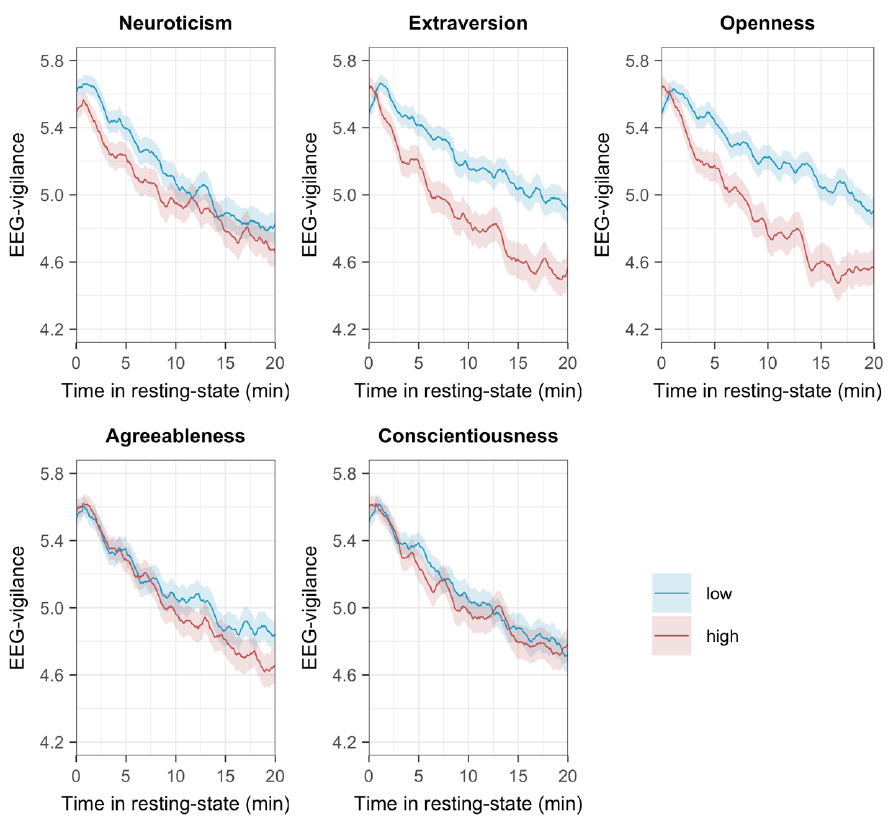
Figure 1. Time-courses of EEG-vigilance during the 20-min eyes-closed resting-state condition stratified by groups scoring low vs. high on the respective Big Five scale (median-split, i.e., participants with scores in the lower vs. upper half of the ascending distribution are compared). Time-courses reflect simple moving averages (± standard errors), i.e., every data point represents an averaged 61-s interval of EEG-vigilance (data point in time ± 30 s). Statistical analyses revealed significant associations between EEG-vigilance and both extraversion and openness to experience.